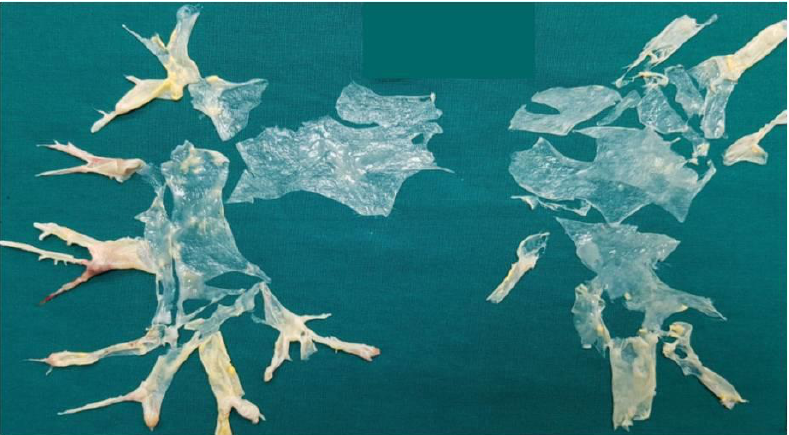
Figure 1. Pulmonary endarterectomy casts from a patient, enrolled in the study, with complex and severe CTEPH. severe